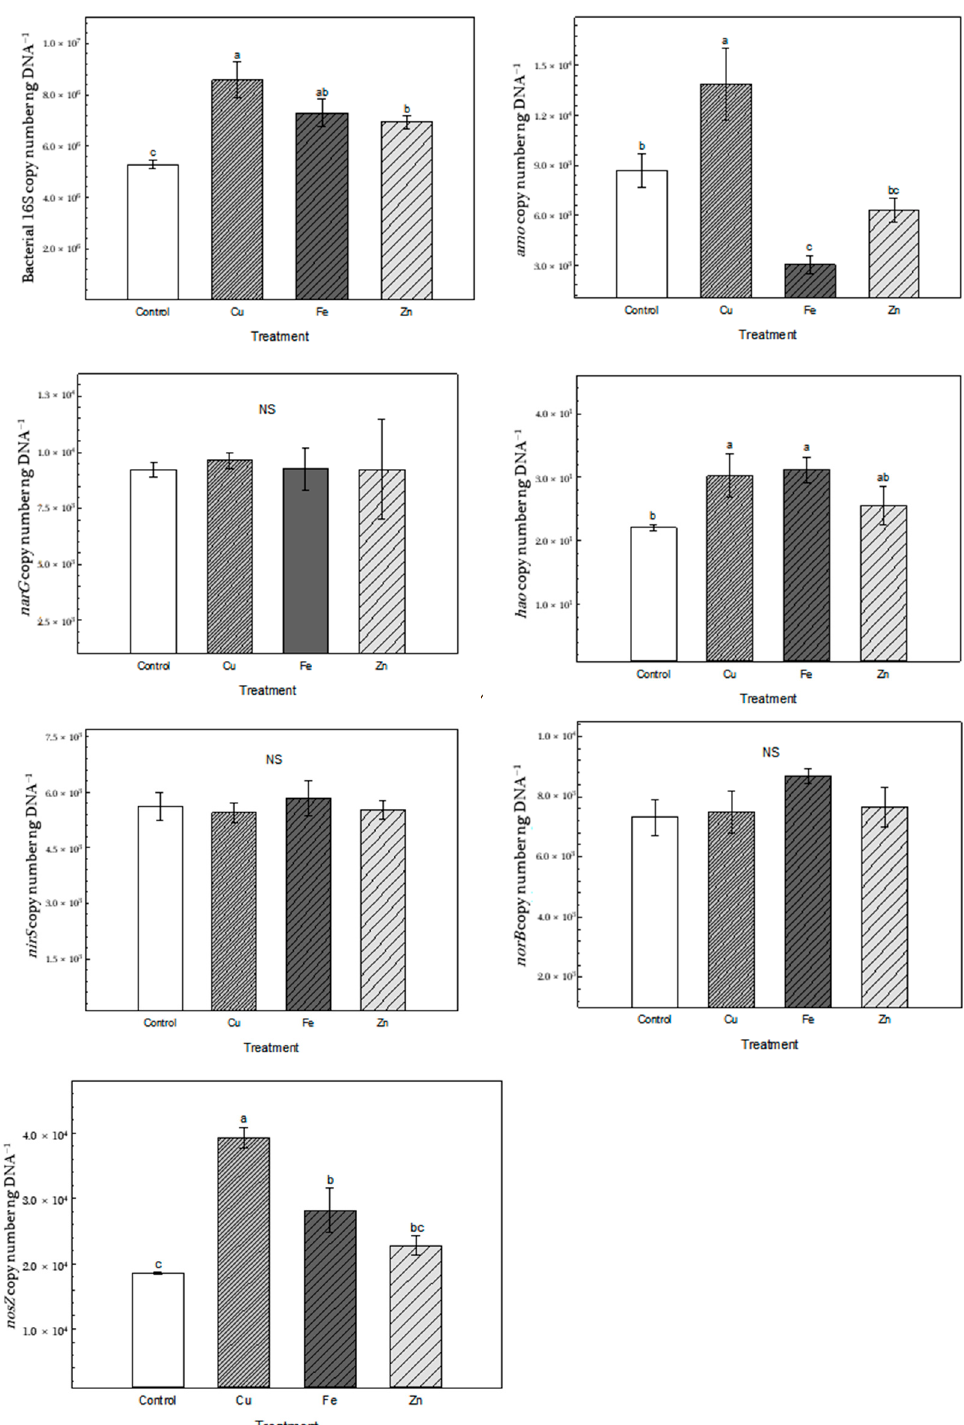
Figure 4. Copy numbers of the amoA gene from AOB and hao , narG , nirS , norB , and nosZ genes in soil amended with different metals at harvest in Year 2. Different lowercase letters denote significant difference at p < 0.05 level.